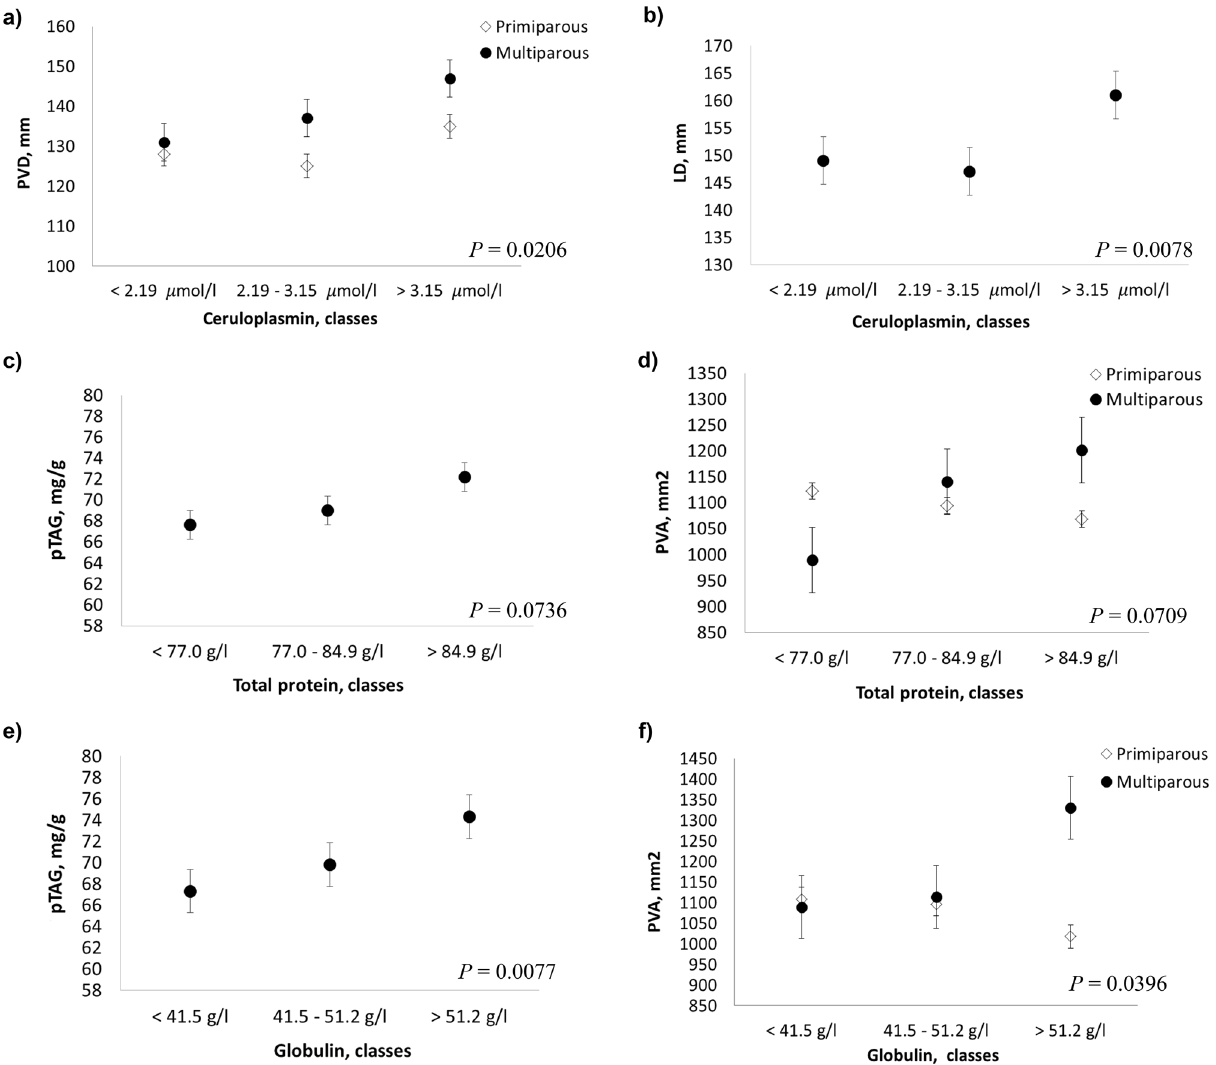
Figure 5. Least squares means (LSM) for predicted liver triacylglycerol (pTAG), portal vein area (PVA) portal vein depth (PVD) and liver depth (LD) across the classes of inflammatory/innate immunity hematic metabolites. ( a , b ) Ceruloplasmin; ( c , d ) total protein; ( e , f ) globulin. Black dots/rhombus indicate the LSM and error bars indicate the standard error.